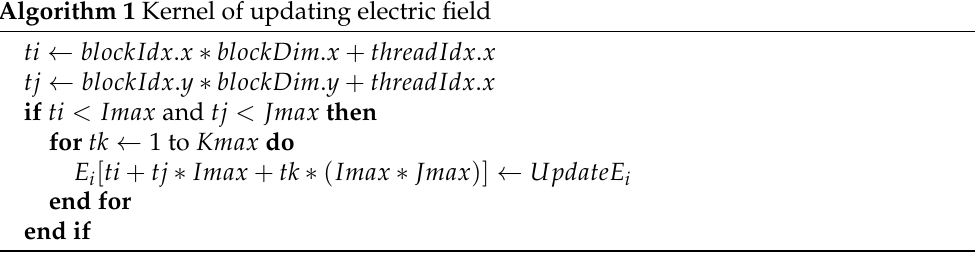
Algorithm 1 Kernel of updating electric